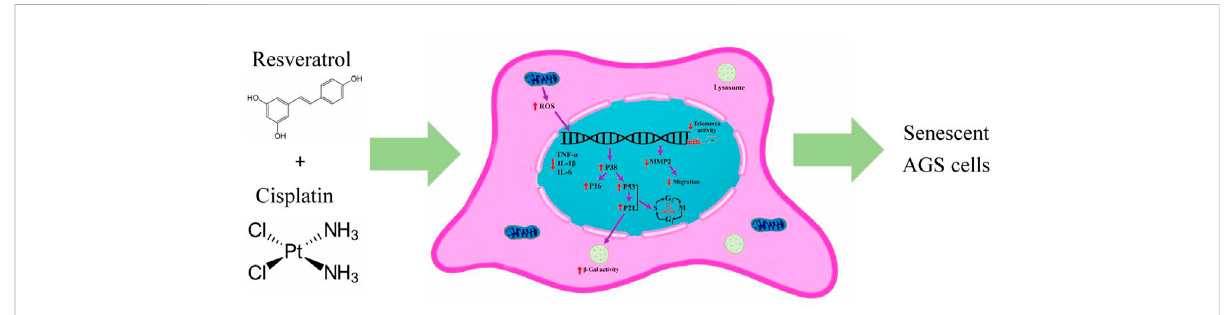
FIGURE 7 The crucial mechanisms involved in present study. Cisplatin and resveratrol in appropriate dose induced aging in AGS cell line. ↑ increased; ↓ decreased; ROS, reactive oxygen species; IL-6, interleukin six; IL-1 β , Interleukin one beta; TNF- α , tumor necrosis factor alpha; MMP2, matrix